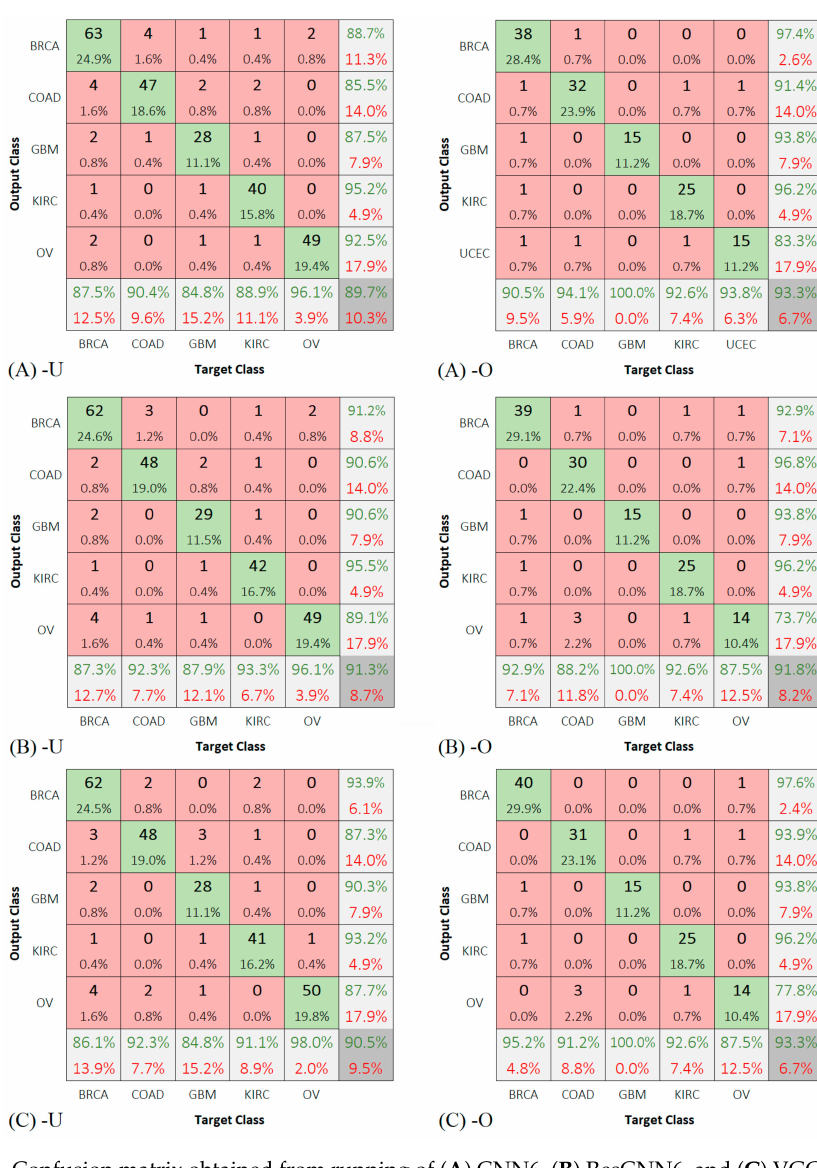
Figure 9. Confusion matrix obtained from running of ( A ) CNN6, ( B ) ResCNN6, and ( C ) VGG16, on the test group of five classes (-U: no UCEC and -O: no OV).